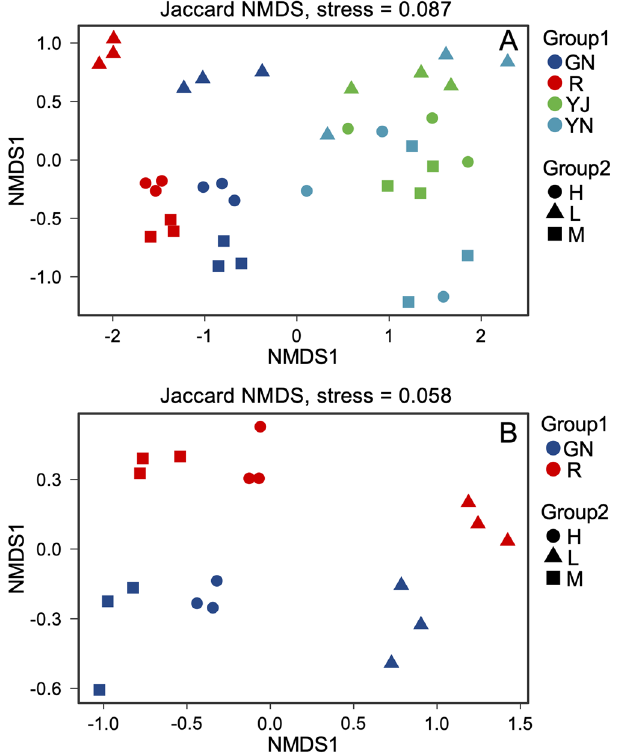
Figure 6. β-diversity of bacterial community structure of pot-experiment rice in different soils based on NMDS